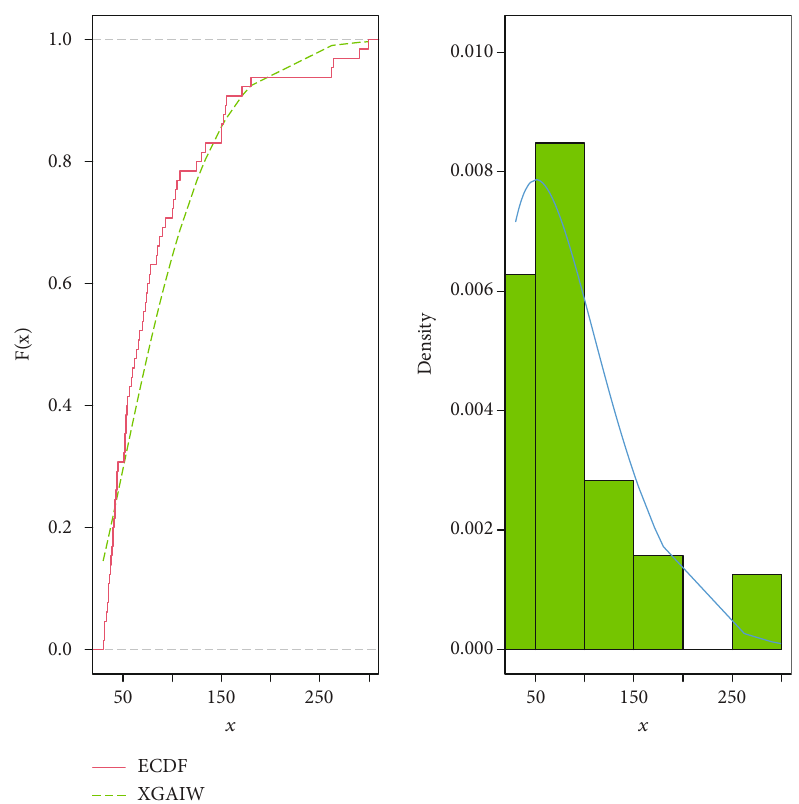
Figure 13: The fi tted PDF and estimated CDF of the XGAIW